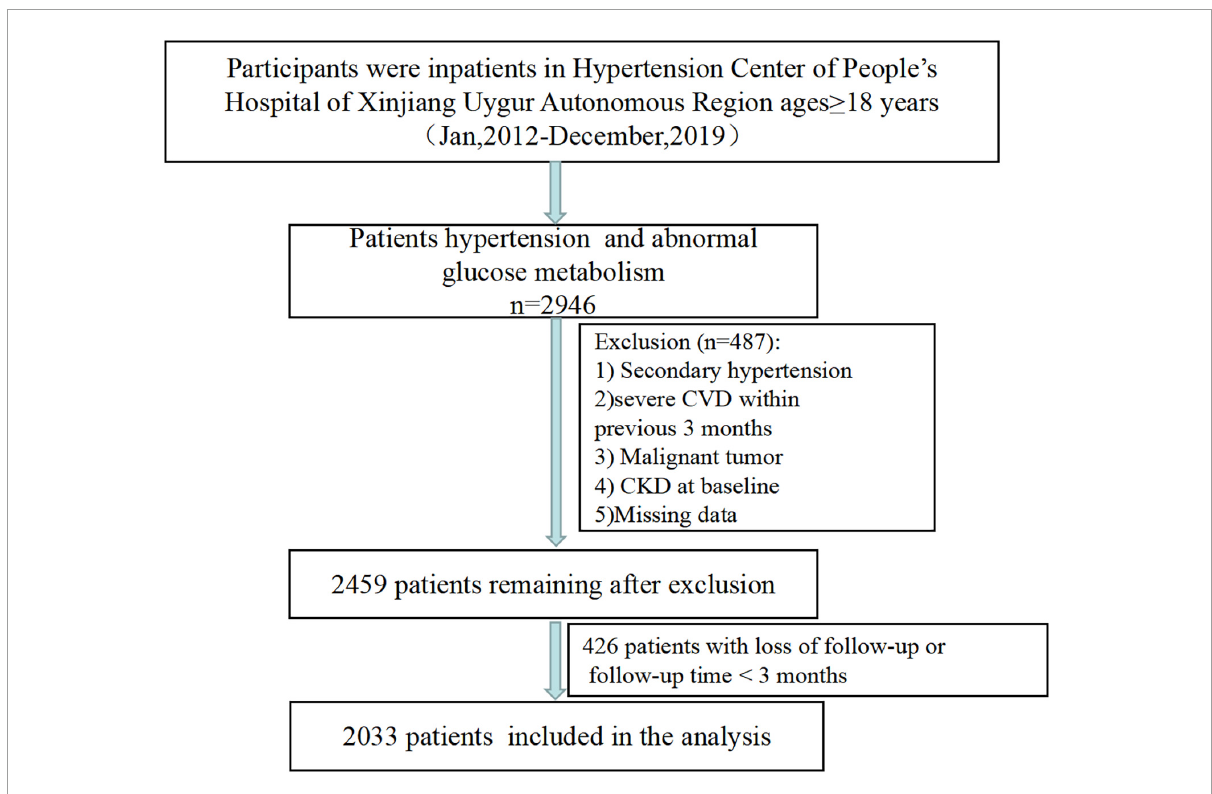
FIGURE1 Patient screening